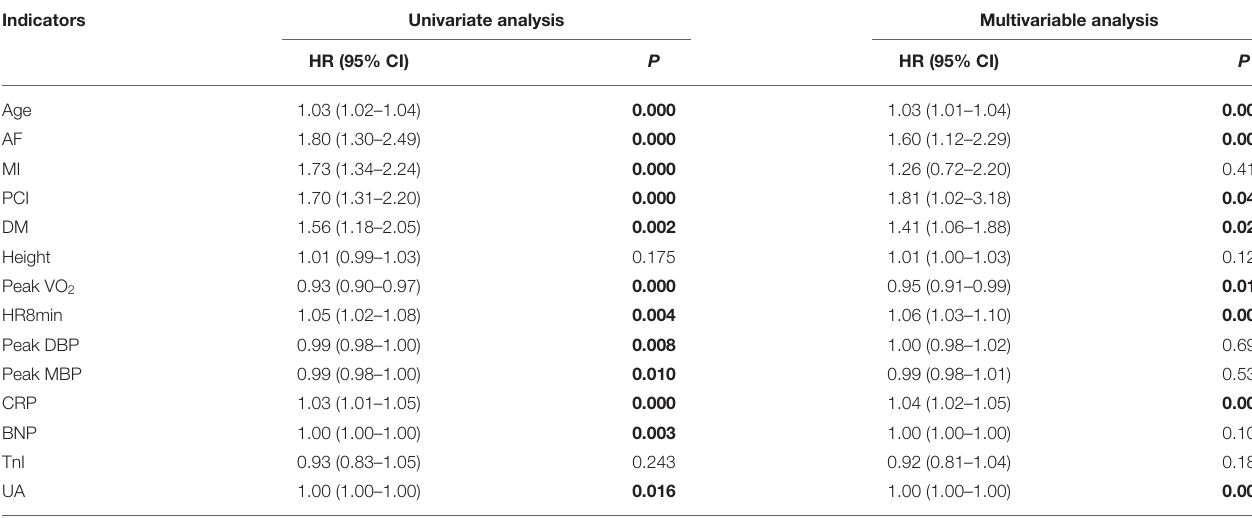
TABLE 2 | Analysis of risk events indicators in chronic heart failure patients. Indicators